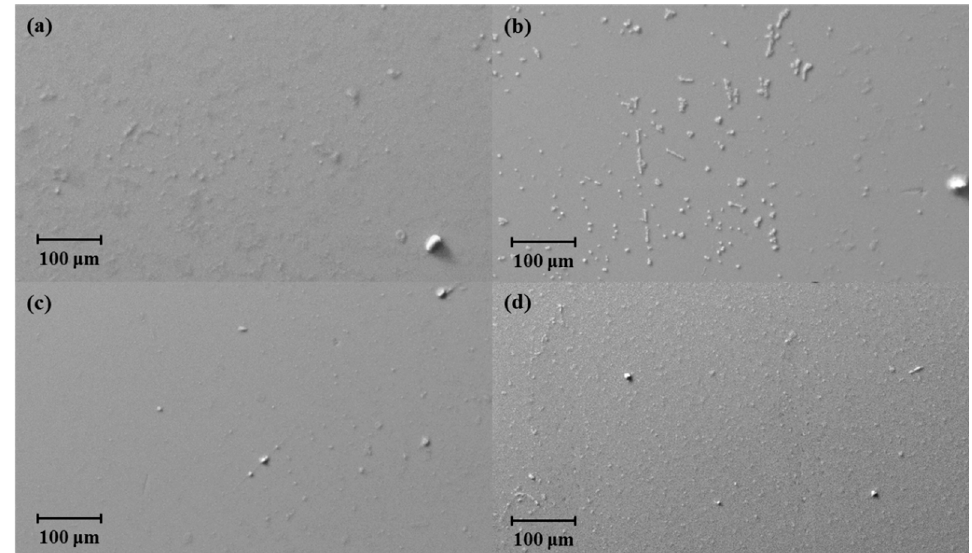
Figure 2. SEM images of polished KCeSZ-1 melt glass slices after 2 h hydrothermal exposures in air with 7% H 2 O at ( a ) 300 °C, ( b ) 500 °C, ( c ) 600 °C, and ( d ) 700 °C. Separate samples were used for each testing condition.